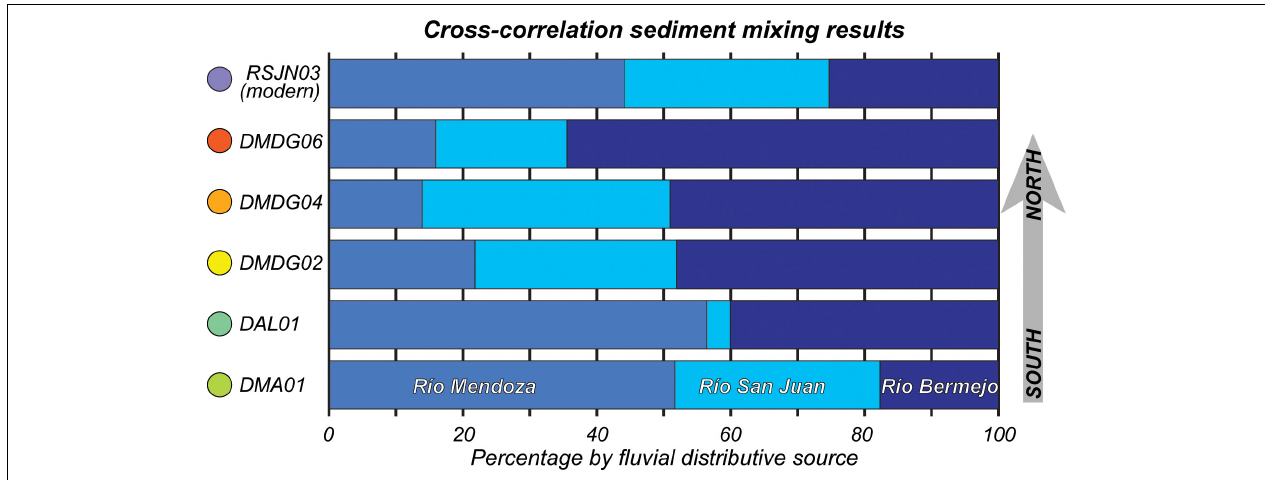
FIGURE 6 | DZ age distribution mixing model results for Holocene eolian and modern distal fluvial samples comparing the relative contribution (in%) from Río Bermejo, Río San Juan, and Río Mendoza age distributions using KDE R 2 cross-correlation coefficient test. Note south to north trend in Holocene eolian samples and equal proportioned modern distal fluvial sample